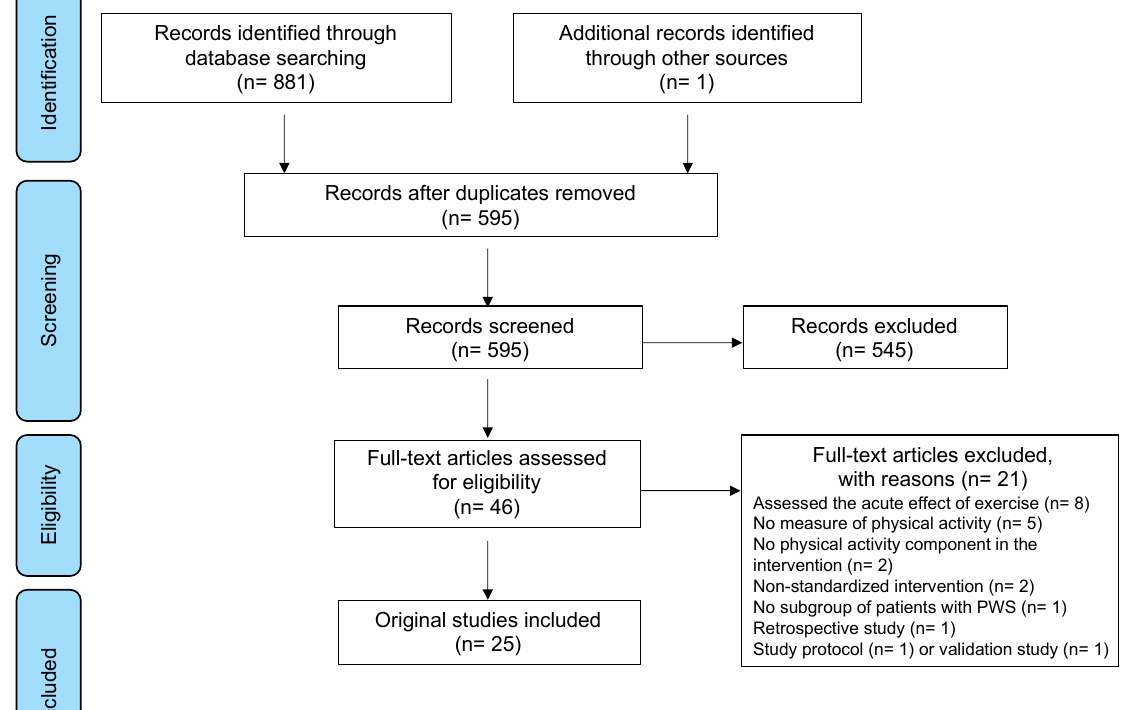
Figure 1. Systematic review flow diagram. Table 1. Study characteristics (N = 25 studies).